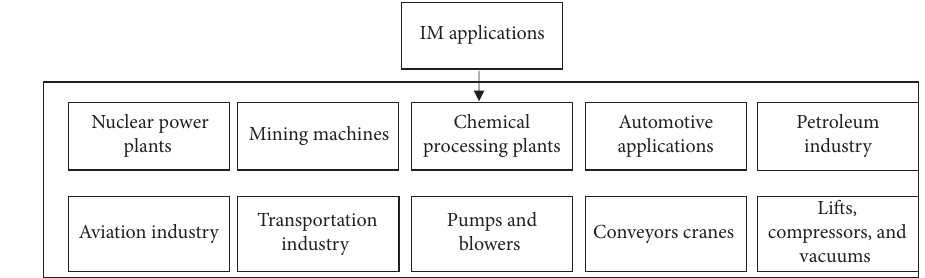
Figure 2: Applications of the IM.